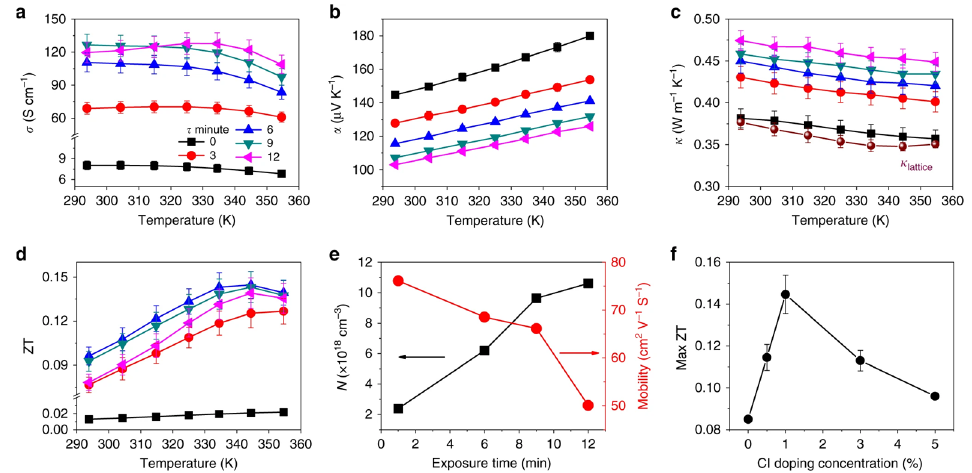
Figure 31. Thermoelectric performance of CsSnI 3-x Cl x (SnCl 2 = 1%) thin films ( a ) Temperature dependence on electrical conductivity, ( b ) Temperature dependence on Seebeck coefficient, ( c ) Temperature dependence on thermal conductivity, ( d ) Temperature dependence on the figure of merit, ( e ) Ambient air exposure time influence on charge density and mobility, ( f ) Figure of merit variation with SnCl 2 substitution. Reproduced from [146] under http://creativecommons.org/licenses/by/4.0/ (accessed on 19 October 2022). Copyright 2019, Springer Nature.